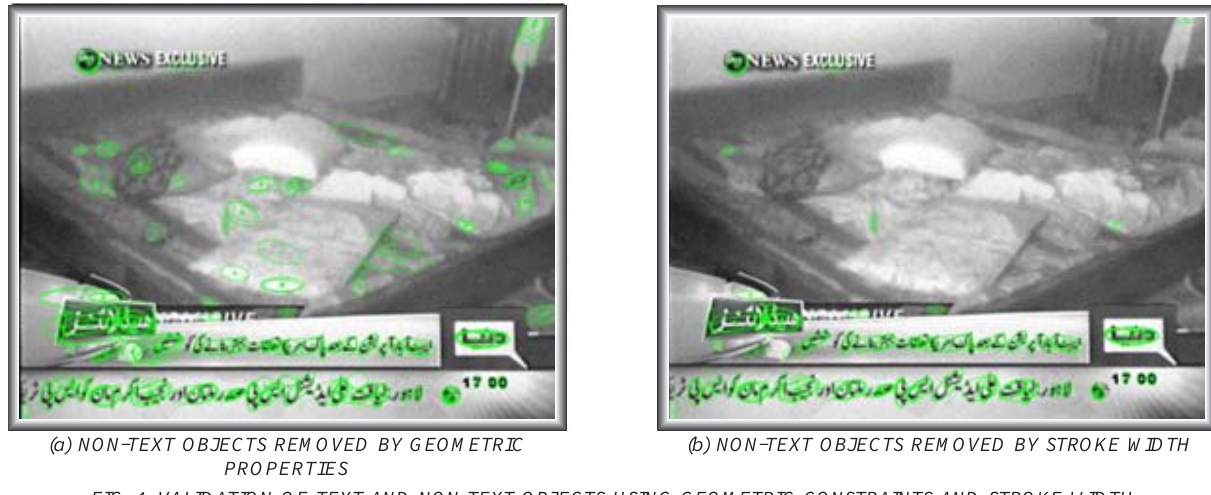
FIG. 4. VALIDATION OF TEXT AND NON-TEXT OBJECTS USING GEOMETRIC CONSTRAINTS AND STROKE